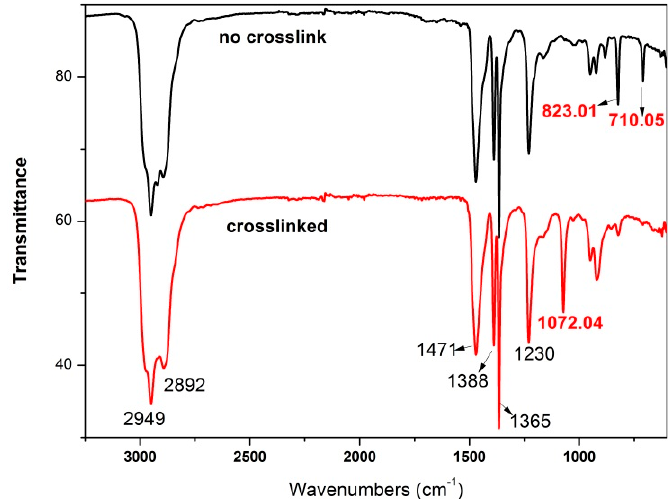
Figure 7. 13 C NMR spectra of the copolymer before thermal crosslinking ( top ) and after thermal crosslinking ( bottom ).